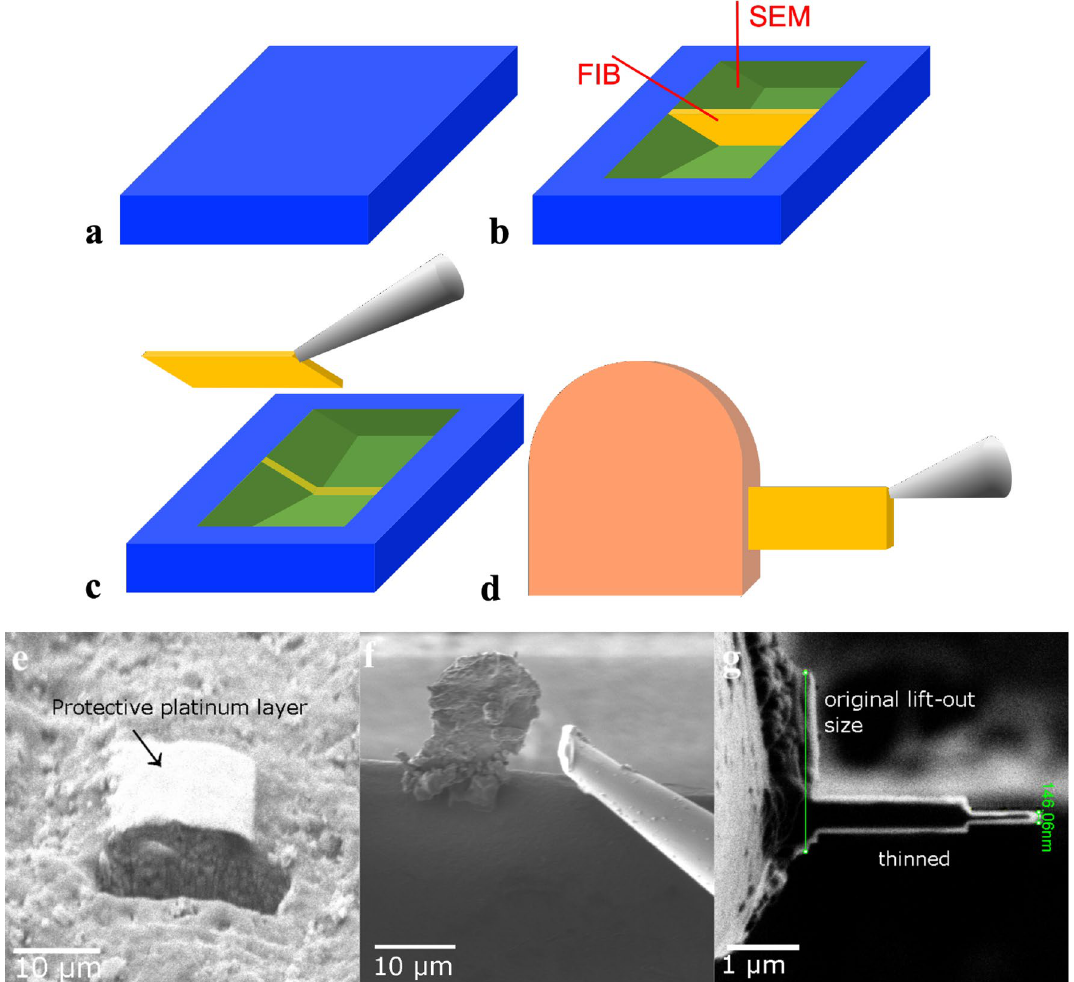
Figure 7. Schematic and example secondary electron images of kerogen lift-out preparation process: ( a ) carbon rich area is identified, ( b ) trenches are milled around the site of interest leaving thin lamella, ( c ) lamella is attached to the Omiprobe nanomanipulator tip using platinum deposition and lamella is cut free by milling sides and bottom, ( d ) lamella is attached to copper grid post with platinum deposition, cut free from the tip and both lamella faces are thinned to electron transparency using gallium ion beam; ( e ) site of interest with platinum deposition on top and a milled trench, ( f ) lamella welded to a copper grid post and Omiprobe nanomanipulator tip already cut free, ( g ) top view of a lamella in the process of